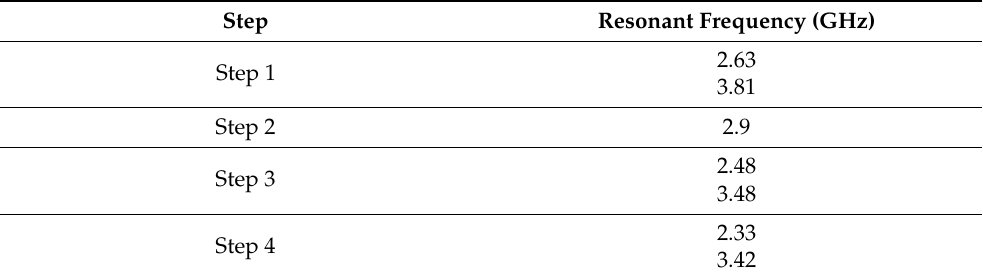
Table 10. Resonant Frequencies of modes for Each Design Step of The Dual Band Antenna Design Using